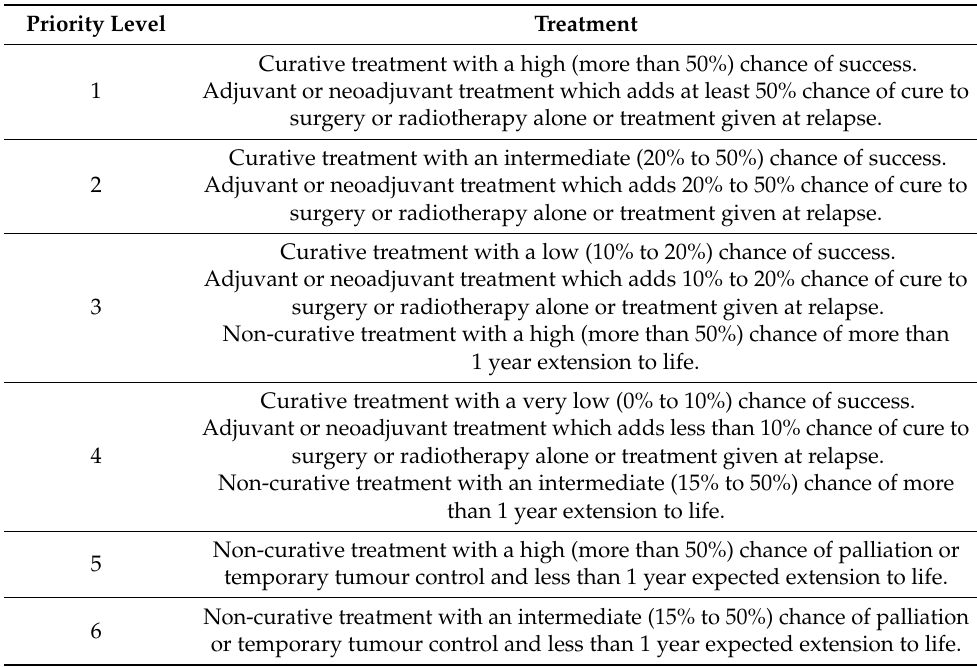
Table 1. Prioritising systemic anticancer treatments. Taken from NICE guideline